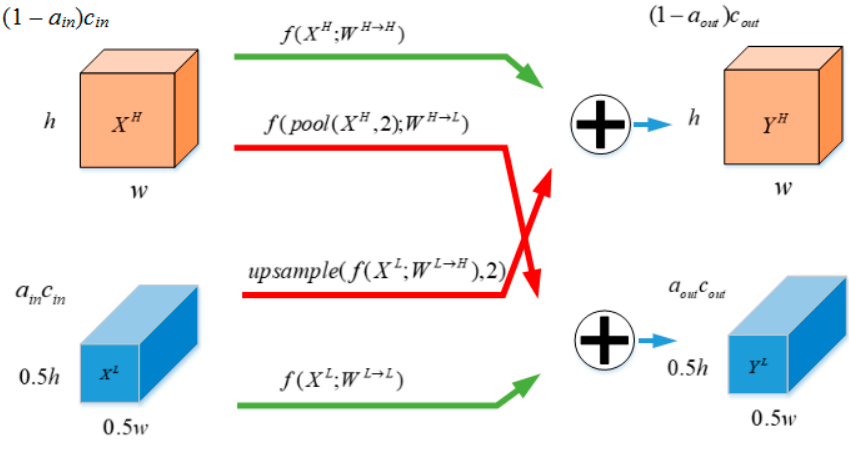
Figure 6. OctConv convolution schematic [60].